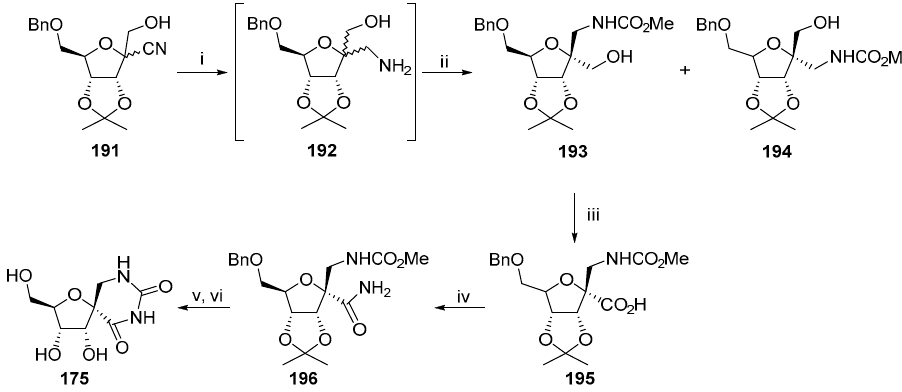
Figure 9. Hydantocidin analogues with miscellaneous spiroheterocyclic